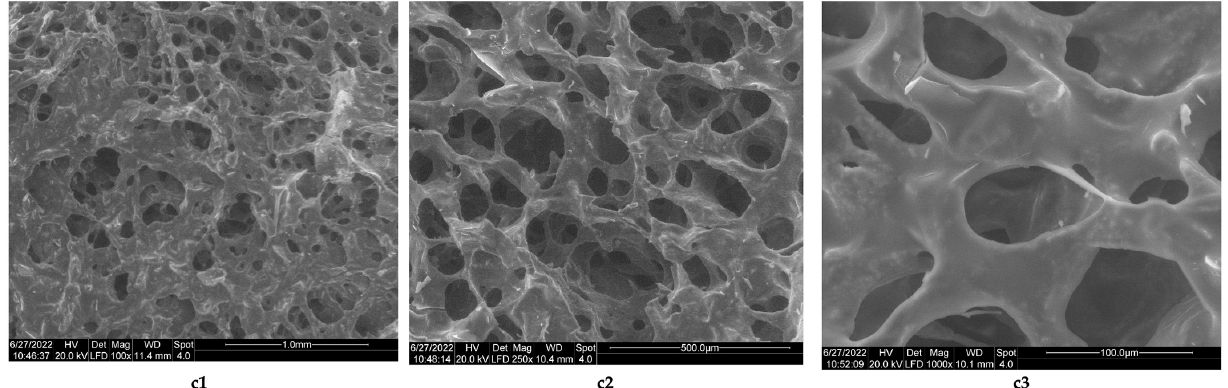
Figure 7. Morphology of composite biomaterial between collagen and chitosan, obtained at a collagen–chitosan mass ratio of 1:1 by lyophilization: ( c1 ) porous structure of the collagen-chitosan sponge, with interconnected pores (magnification 100×); ( c2 ) details regarding interconnected pore geometry (magnification 250×); ( c3 ) pore geometry, with dimensions of 100 μ m (magnification 1000×).